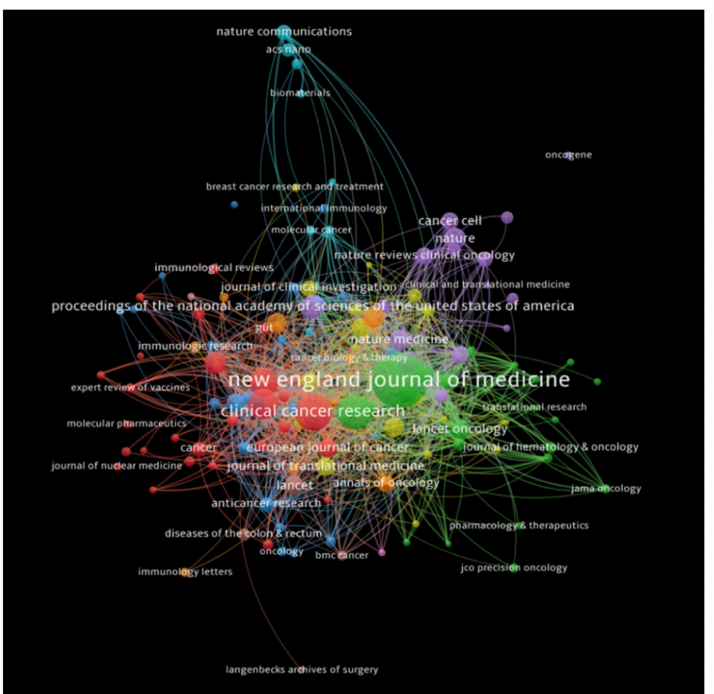
Figure 5. Bibliometric analysis of the journals in the publications of immunotherapy in CRC showing journals receiving top citations, where the size of nodes indicates the number of citations